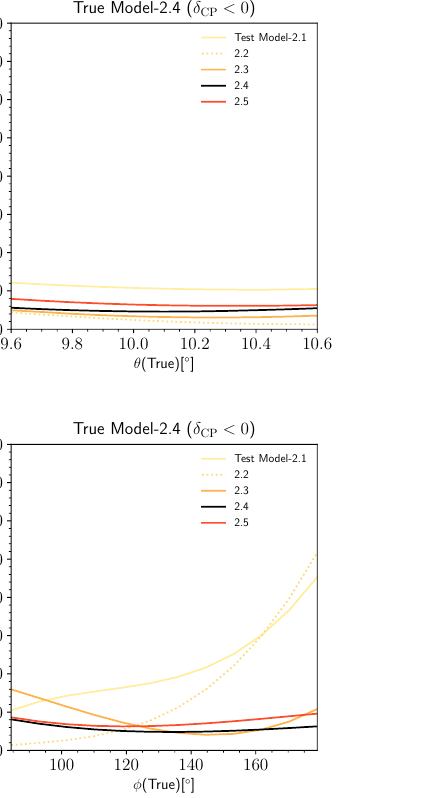
Figure 7 . Comparison among the (cid:12)ve allowed two-parameter models as test models for ESSnuSB using priors in the cases the model parameters (cid:30) (upper row) and (cid:18) (lower row) are minimized and corresponding to the (cid:12)rst (left column) and the second (right column) best-(cid:12)t points in table 8 for Model 2.4 as the true model. For description of each panel, see (cid:12)gure